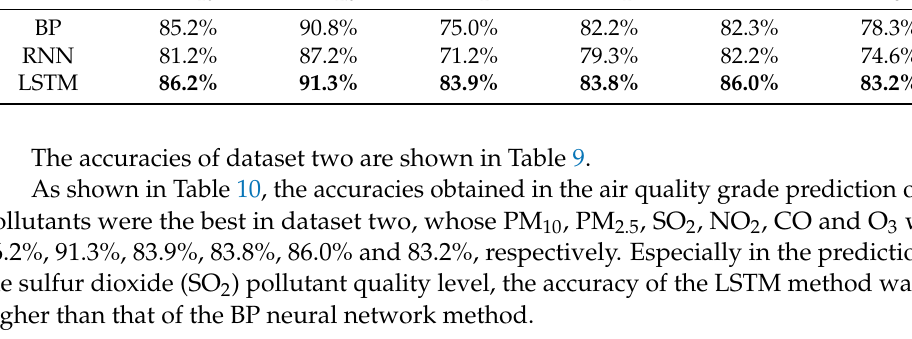
Table 9. The accuracies of LSTM network compared with traditional networks in dataset 2. Methods